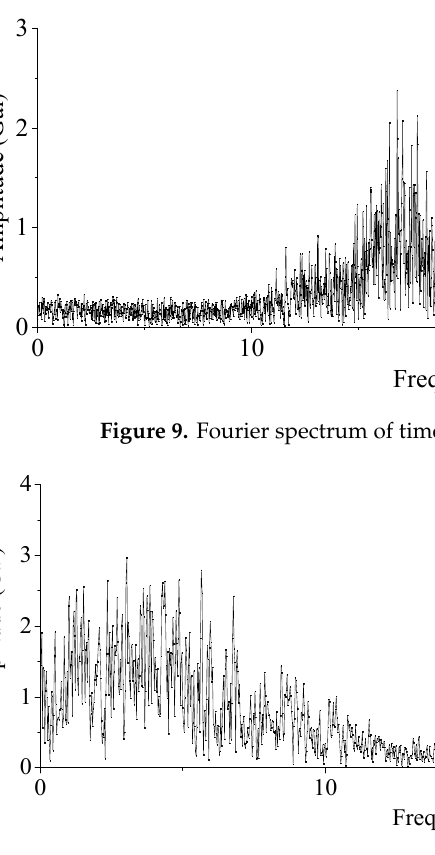
Figure 7. Loading steps.